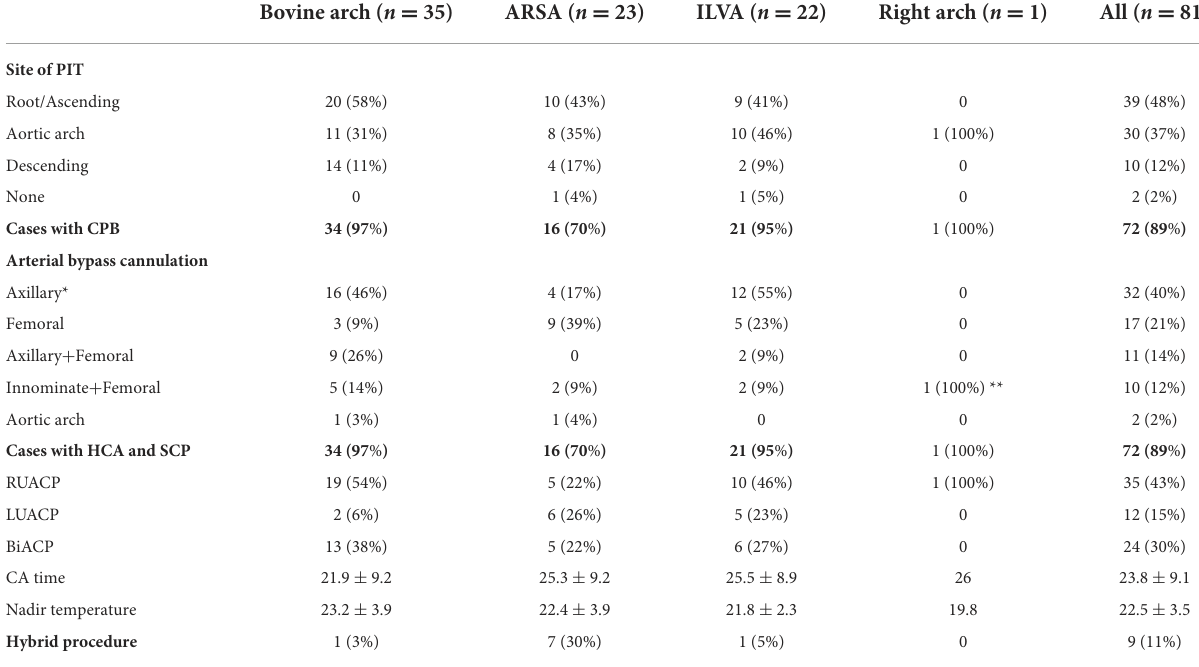
TABLE 3 Surgical characteristics.